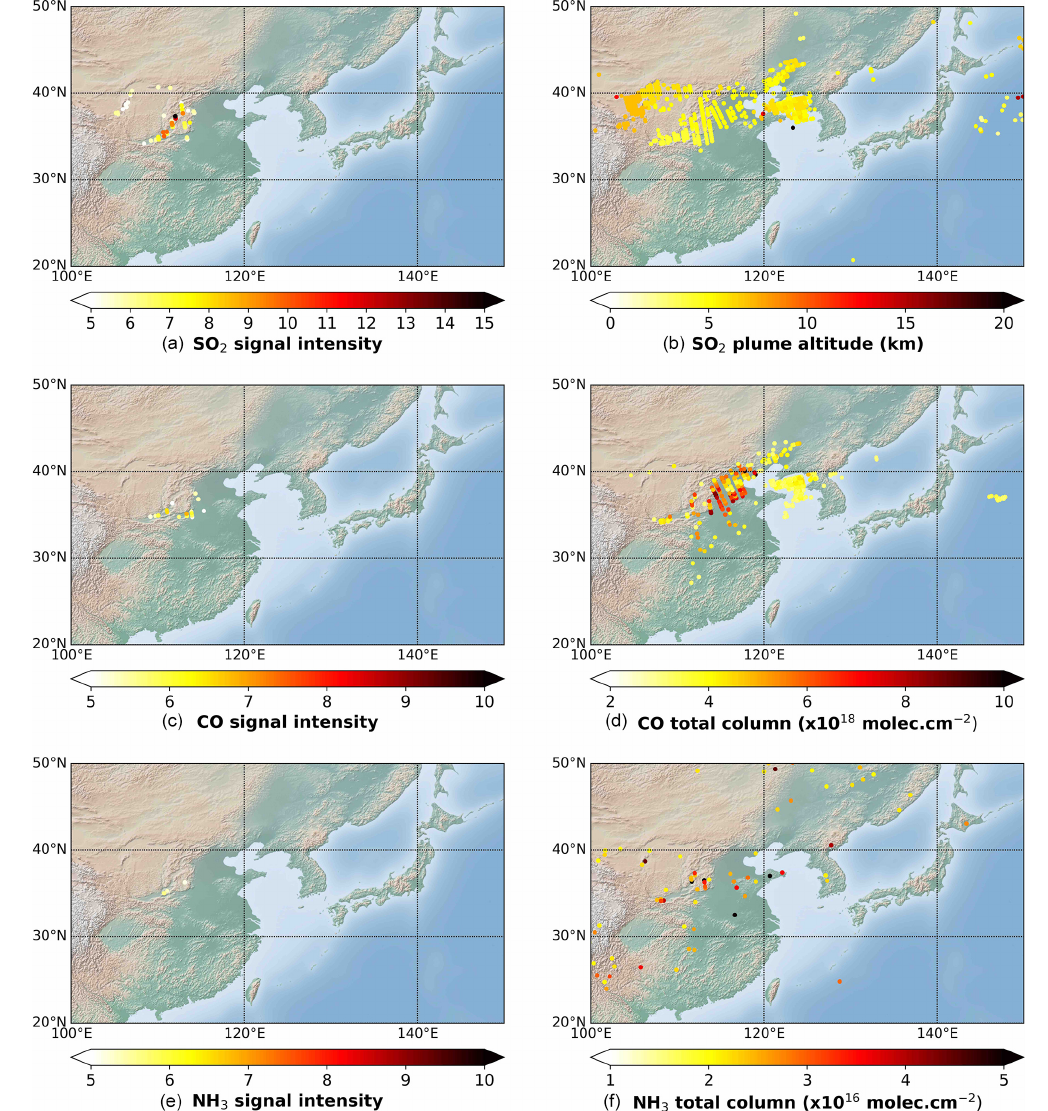
Figure 12. Analysis of an intense fire event in China on 13 January 2013 in the evening (nighttime or PM orbit) based on IASI/Metop-A L1C data. (a, c, e) Spatial distribution of residual values associated with SO 2 , CO, and NH 3 . (b, d, f) SO 2 plume altitude retrievals (km) and CO and NH 3 total column retrievals (molec.cm − 2